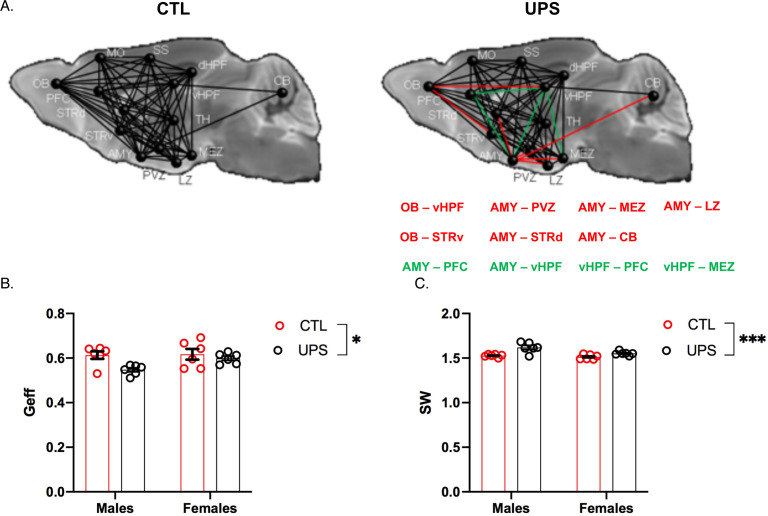
Effects of unpredictable postnatal stress (UPS) and sex on global connectivity.(A) Schematic representation of global connectivity for control (CTL) and UPS. Red lines indicate reduced connectivity and green lines indicate increased connectivity compared to CTL group. (B) Quantification of global efficiency (Geff) and (C) Small-worldness (SW). (n = 6 per rearing and sex group). Mean and SEM, *p<0.05. Abbreviations: amygdala (AMY), cerebellum (CB), dorsal hippocampus (dHP), dorsal striatum (STRd), lateral hypothalamic zone (LZ), medial hypothalamic zone (MEZ), motor cortex (MO), olfactory bulb (OB), periventricular zone (PVZ), prefrontal cortex (PFC), somatosensory cortex (SS), thalamus (TH), ventral hippocampus (vHP), ventral striatum (STRv).Figure 8—source data 1.GRETNA codes used for global connectivity analysis.